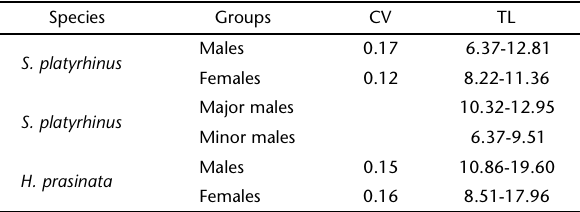
Table II. Amplitude of the total length (mm) for males and females of S. platyrhinus and H. prasinata (n = 34, males = 25 and females =